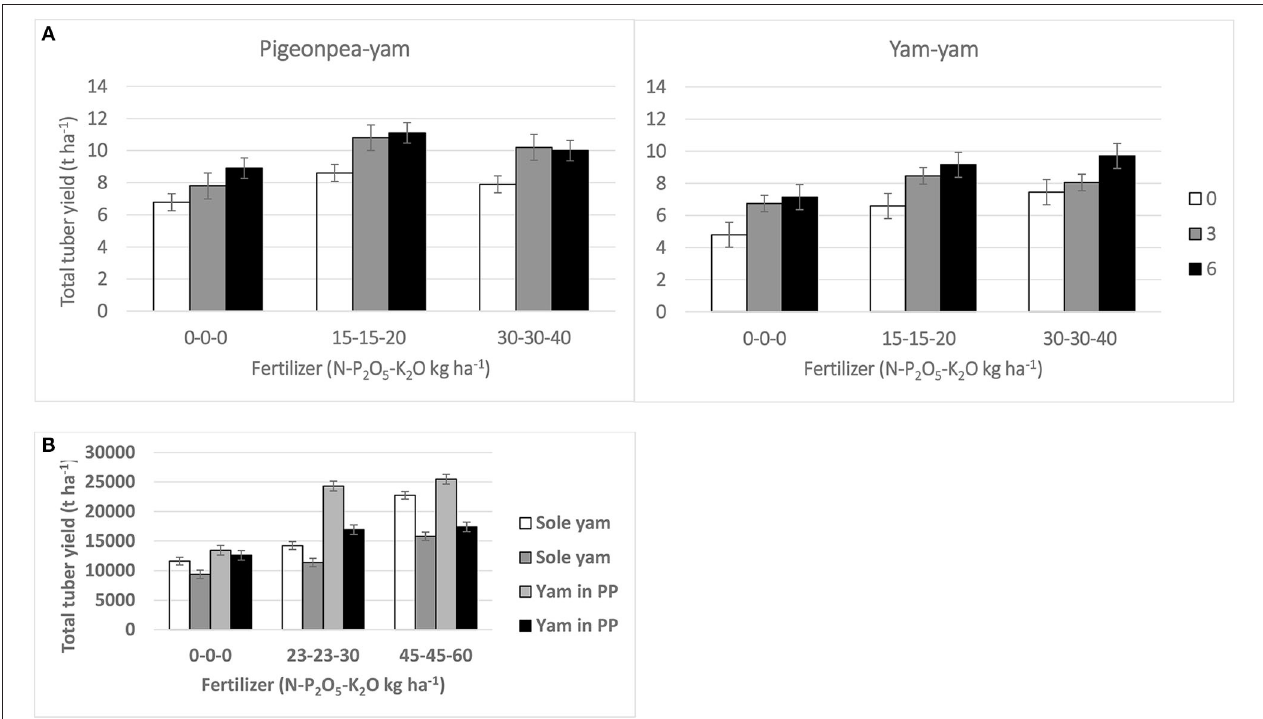
FIGURE 10 | (A) Integrated Soil Fertility Management (ISFM) reduced the inorganic and organic fertilizer (poultry manure) requirement to a third and half respectively for yam production (0–0–0, 15–15–20, 30–30–40 N–P 2 O 5 -K 2 O kg ha − 1 ) Source: Owusu Danquah et al. (2017). (B) Integrated Soil Fertility Management (ISFM) reduced the organic fertilizer requirement to half and improved the tuber yield. PP, pigeonpea biomass. Source: Owusu Danquah